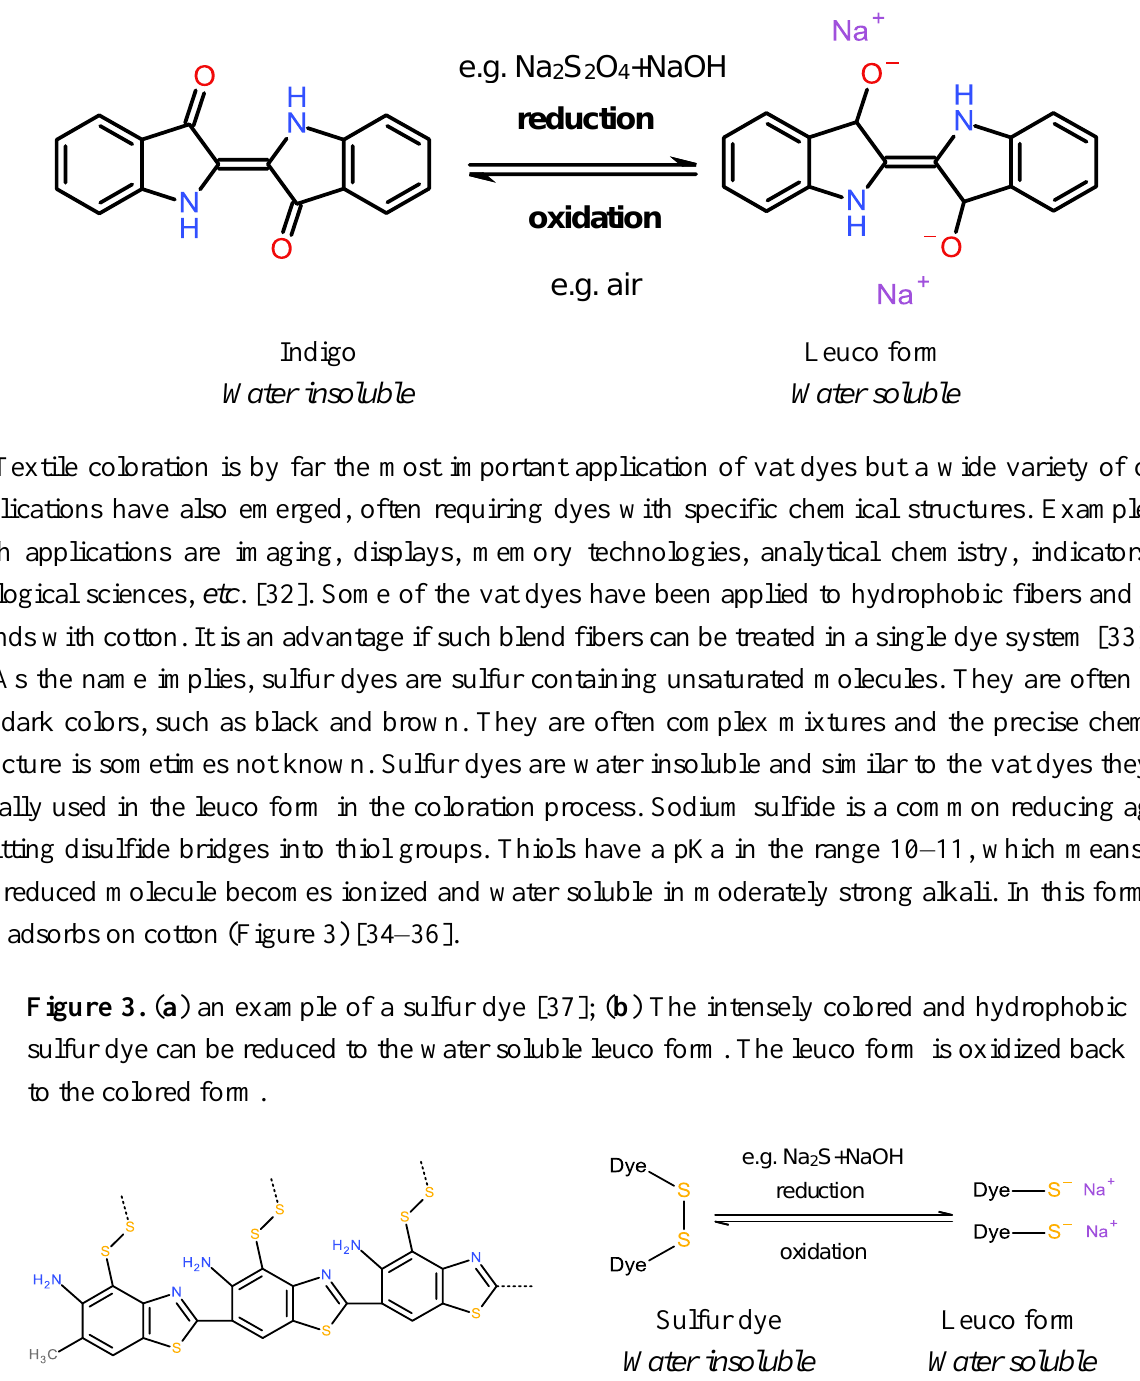
Figure 2. The intensely colored and hydrophobic indigo dye can be reduced to water soluble leuco form. The leuco form is easily oxidized back to indigo.